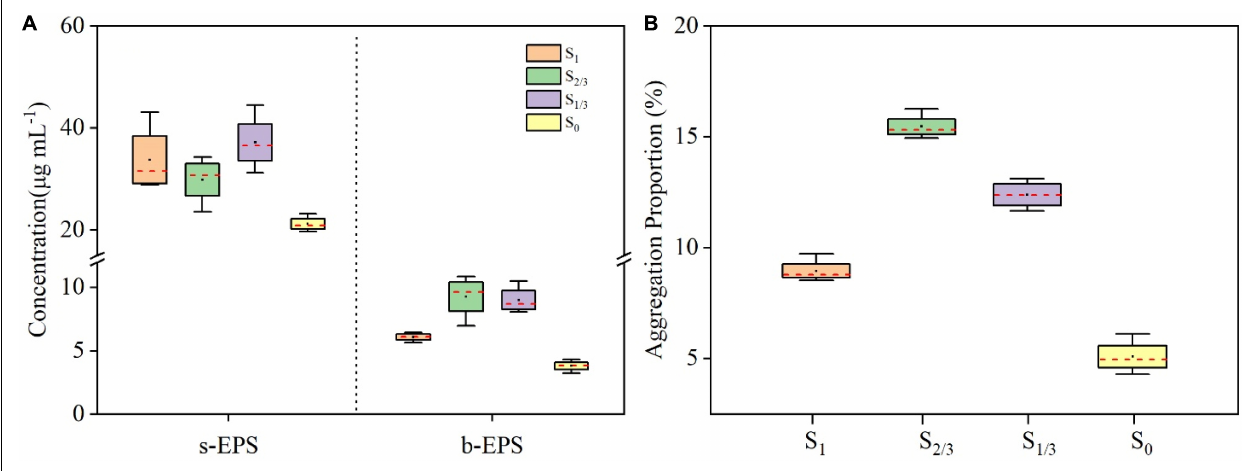
FIGURE 3 | Changes of soluble EPS (S-EPS) in the growth environment of algae and binding EPS (B-EPS) on the surface of algae cells contents (A) and aggregation proportion (B) in each group. The upper and lower boundaries represent the smallest observed value (lower edge) and the largest observed value (upper edge), the black dot in the middle is the mean, and the red dotted line is the median